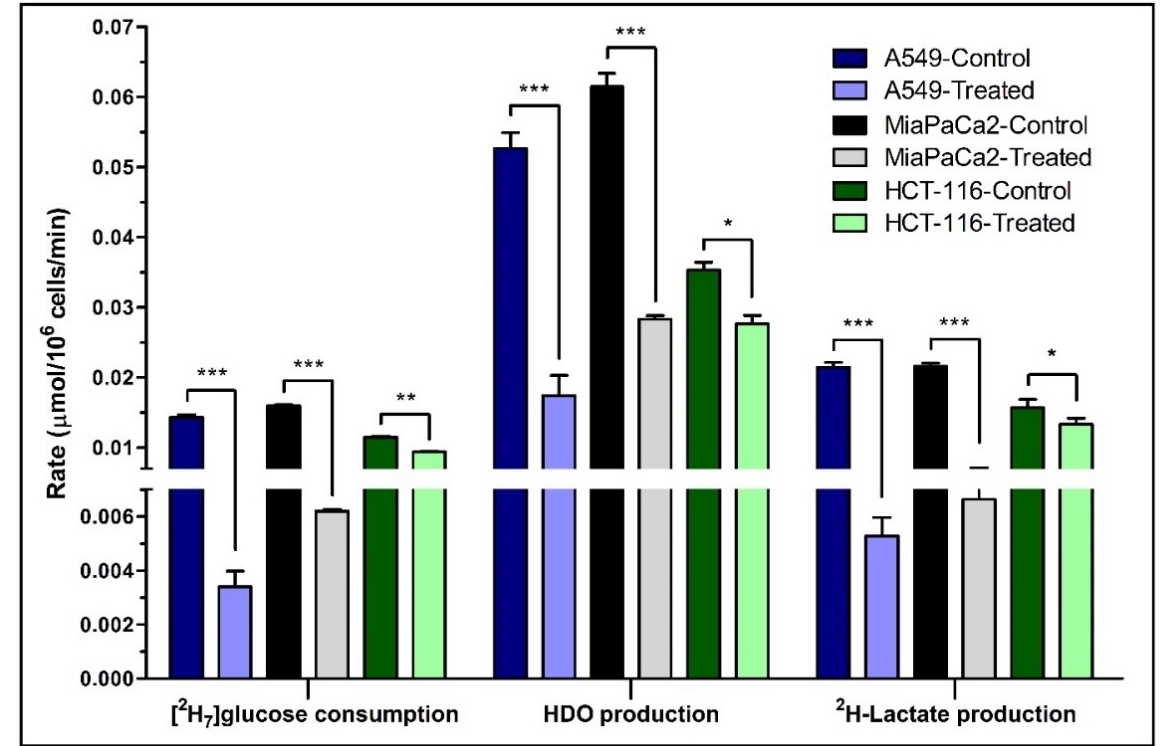
Figure 3. The rates of [ 2 H 7 ]glucose consumption and HDO/ 2 H-lactate production. The consumption rate of [ 2 H 7 ]glucose and production rates of HDO and 2 H-lactate are shown for the post-treatment period. Rates were calculated from the kinetic data of control and β -lapachone treated A549, MiaPaCa2 and HCT-116 cancer cells. Biological triplicate data are represented as mean ± SEM. Significance levels between the slopes of control and treatment groups were determined using the statistical analysis in Graphpad Prism and shown as: “*” if p ≤ 0.05, “**” if p ≤ 0.01, and “***” if p ≤ 0.001.